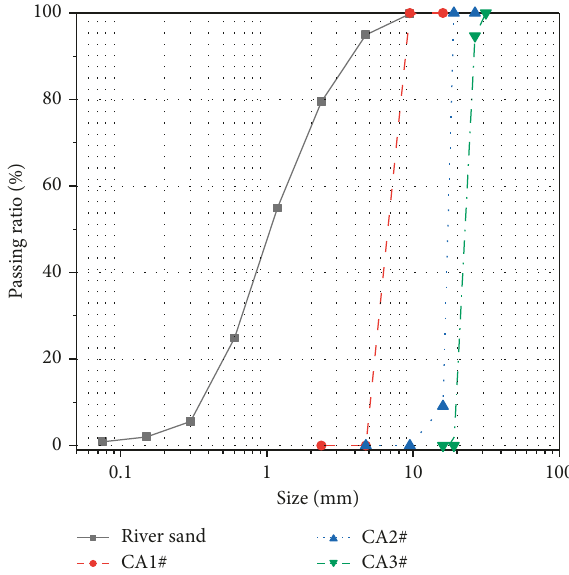
Figure 1: Gradation curves of fine and coarse